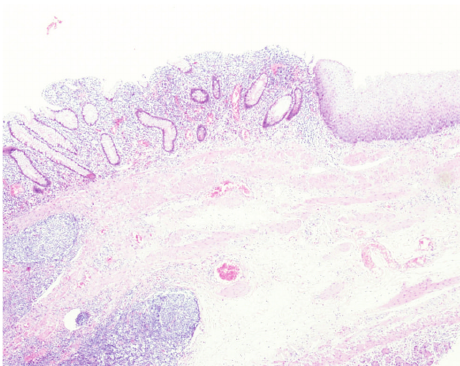
Figure 4: The resected specimen shows ileal mucus gland and esophageal squamous epithelium (HE ×